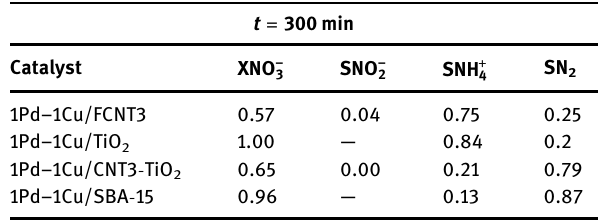
Table 5: Nitrate conversions ( XNO 3− ) and nitrite, ammonium, and nitrogen selectivities ( S NO 2− , S NH 4 + , SN 2 ) of some of the prepared supported catalysts prepared by method 2 and reduced at 200°C at the end of the catalytic reduction ( C NO pH ≈ 5.5